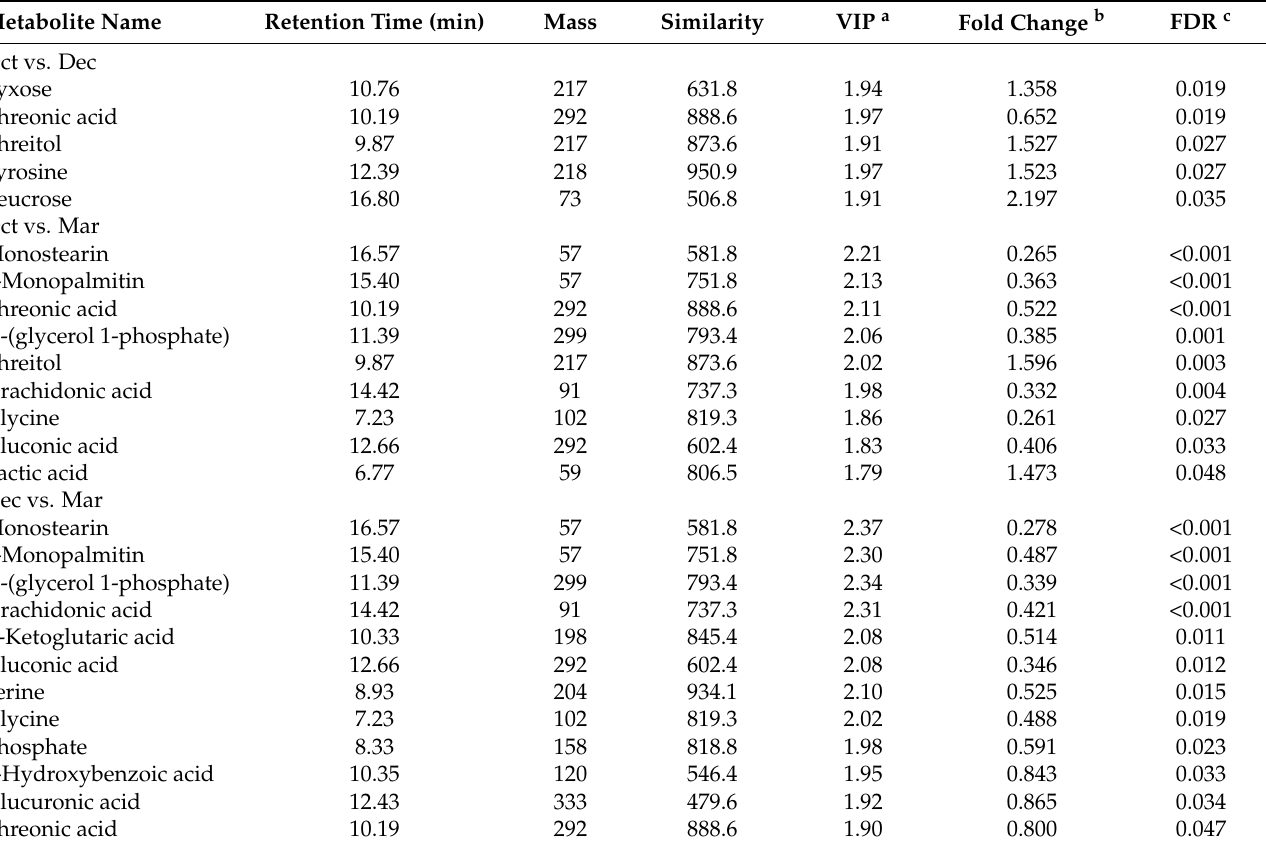
Table 3. Differential serum metabolites in yaks grazing in different months of the cold